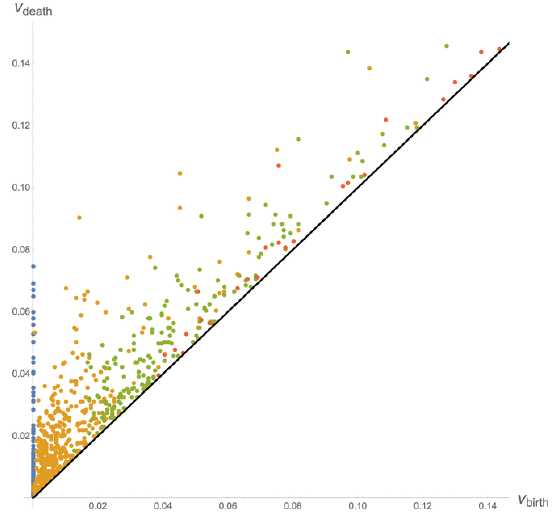
Figure 14 . Small-scale structure of W = 0 vacua. Long-lived higher-dimensional cycles are present in the distribution well after there is only one connected component left. Restricting to W = 0 vacua increases the topological complexity of the